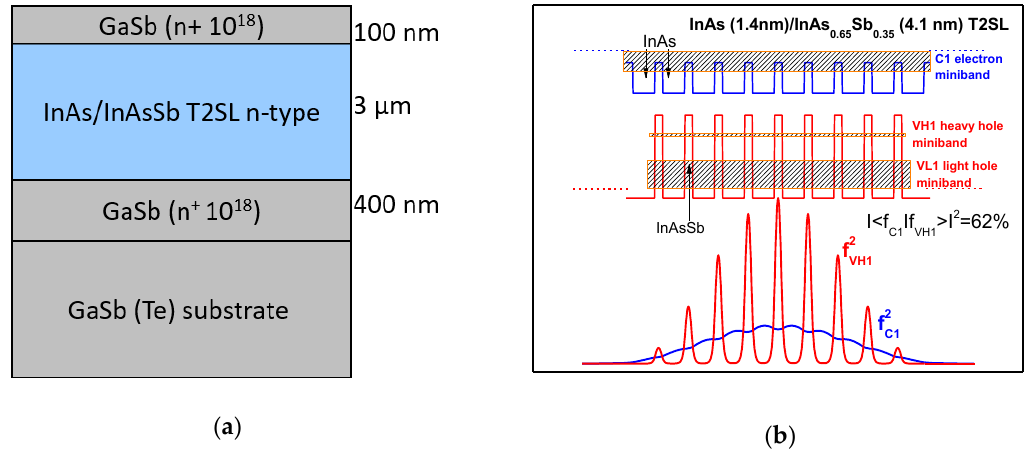
Figure 1. ( a ) Schematic cross section of the type-II superlattice (T2SL) structure dedicated to structural and optical measurements. ( b ) Schematic band diagram and first electron and hole minibands of Ga-free ( a ) T2SL structures. On the lower part, the fundamental electron (C1) and heavy hole (VH1) presence probability densities are reported.